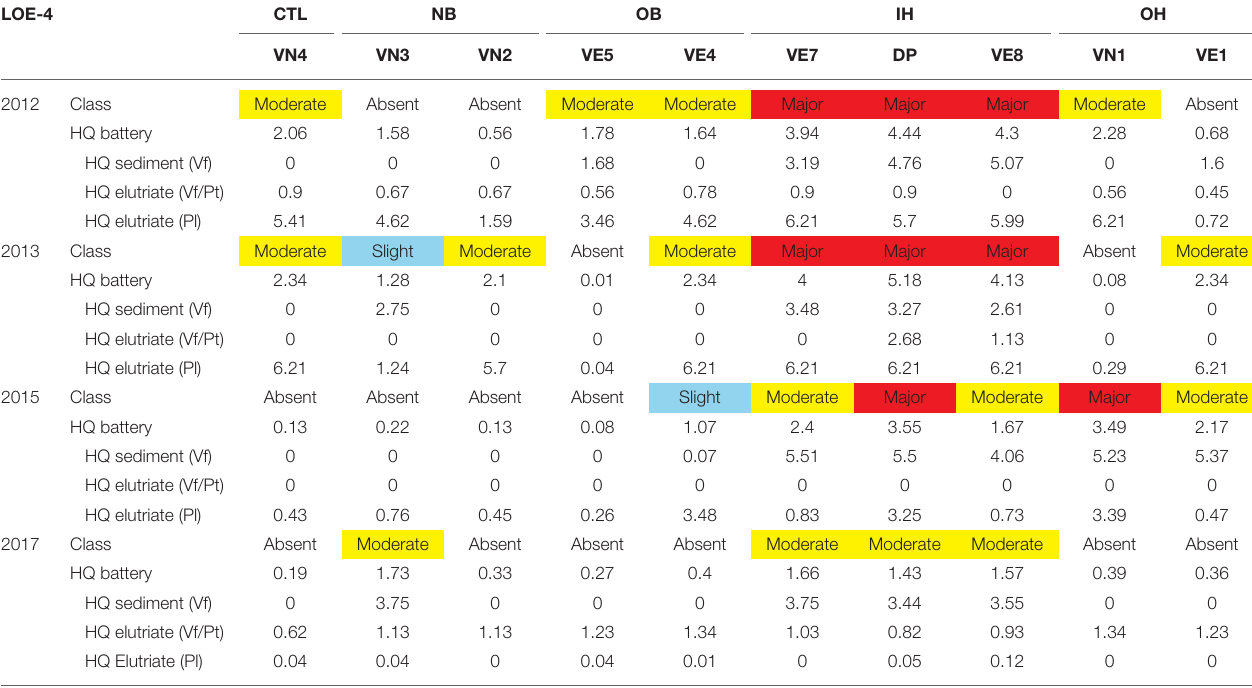
TABLE 4 | Results of the weighted elaboration of bioassays results, LOE-4.